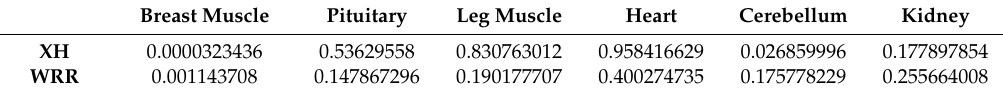
Figure 6. The expression levels of SOX6 in XH and WRR chickens with different copy numbers. ( a , b ) The relative expression levels of SOX6 in six tissues of both XH chicken with CN = 2 or 3 and WRR chicken with CN = 1, 2 or 3, respectively. The Significance: * indicates p < 0.05. Table 7. The significance of association between SOX6 RNA expression and copy number ( p -value).